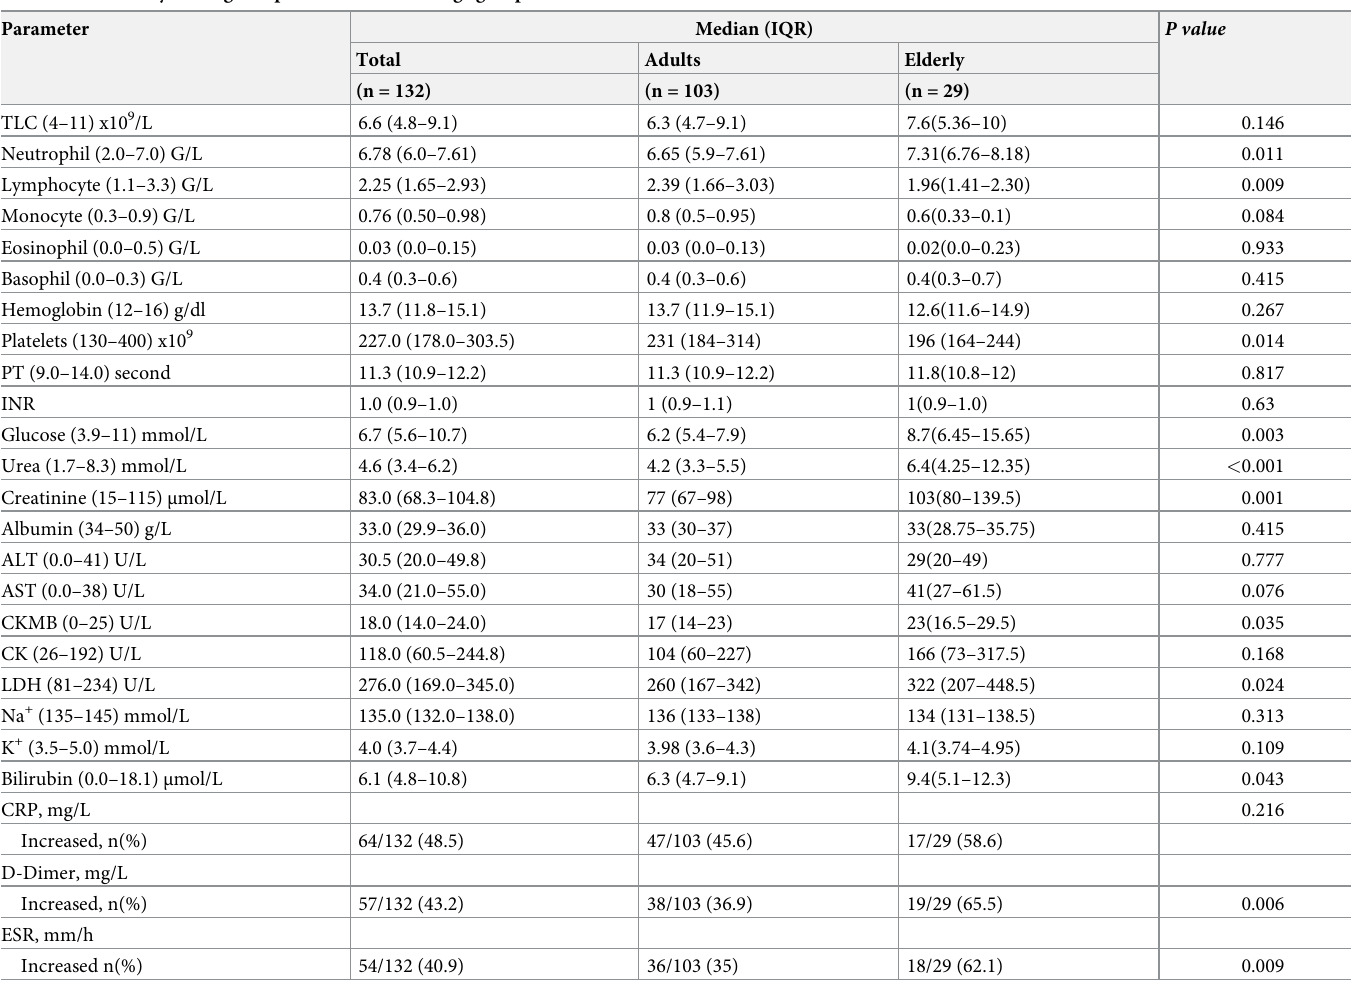
Table 2. Laboratory findings for patients of different age groups with confirmed